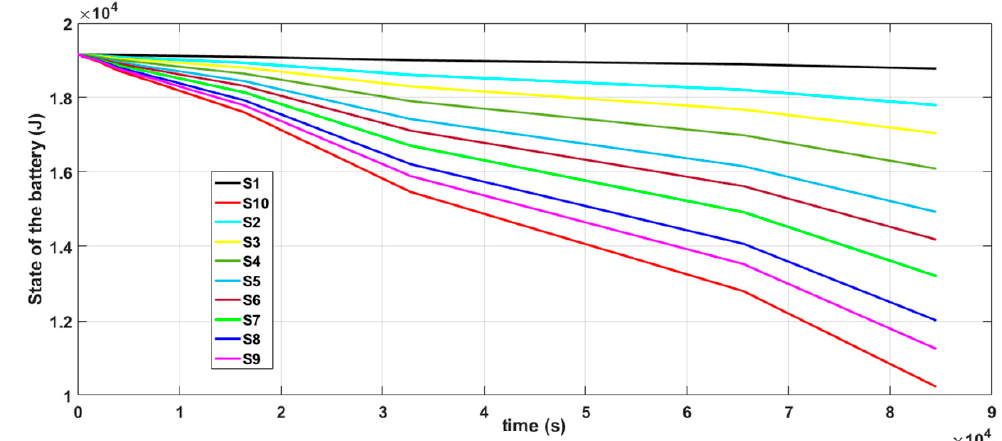
Figure 18. State of the battery of sensor nodes in centralized implementation.